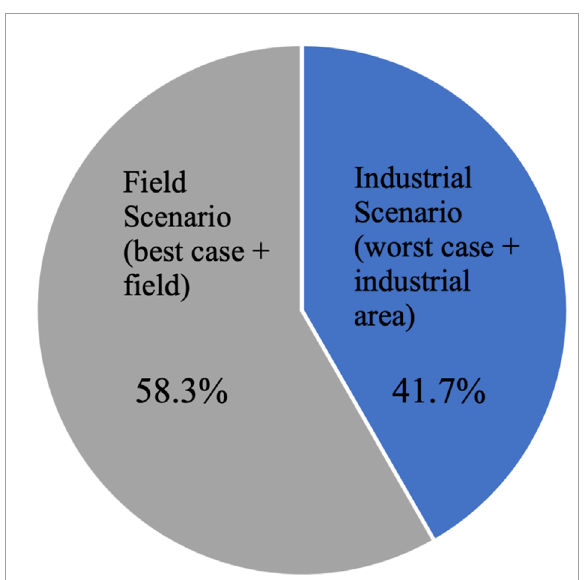
FIGURE 7 Preference simulation for the locations industrial area and field